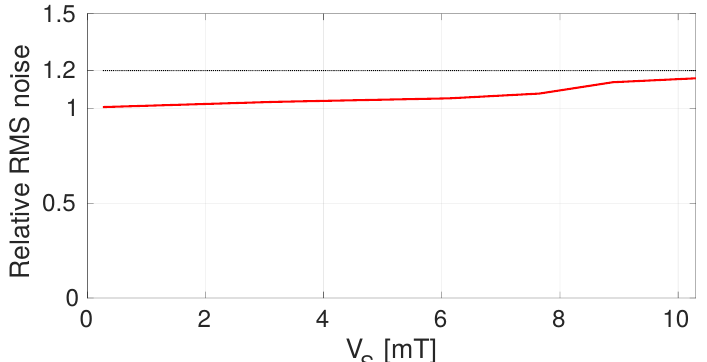
Figure 13. The measurement input-referred RMS noise divided by the measured intrinsic input- referred RMS noise level obtained by traditional spinning as a function of the DC input level (in red). The SS-ORLs from Figure 7 are active and settled, operating with an α value calculated using (23). In black, the 20%-threshold is shown.